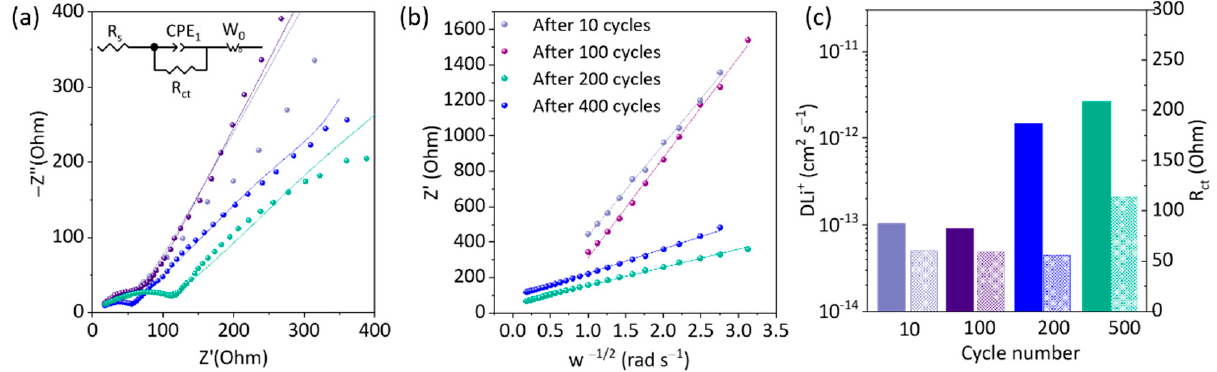
Figure 4. ( a ) Nyquist plot of 2D α -Ge 1 mg cm − 2 semi-cell after 10 cycles (light purple dots), 100 cycles (dark purple dots), 200 cycles (green dots) and 400 cycles (blue dots). ( b ) Z real as function of w − 1/2 for 2D α -Ge 1 mg cm − 2 semi-cell after 10 cycles (light purple dots), 100 cycles (dark purple dots), 200 cycles (green dots) and 400 cycles (blue dots). ( c ) Li + diffusion coefficients ( D Li + ) (filled columns) and charge-transfer resistance (R ct ) (dashed columns) during 400 cycles at constant current 0.5 C for 2D α -Ge 1 mg cm − 2 semi-cell.